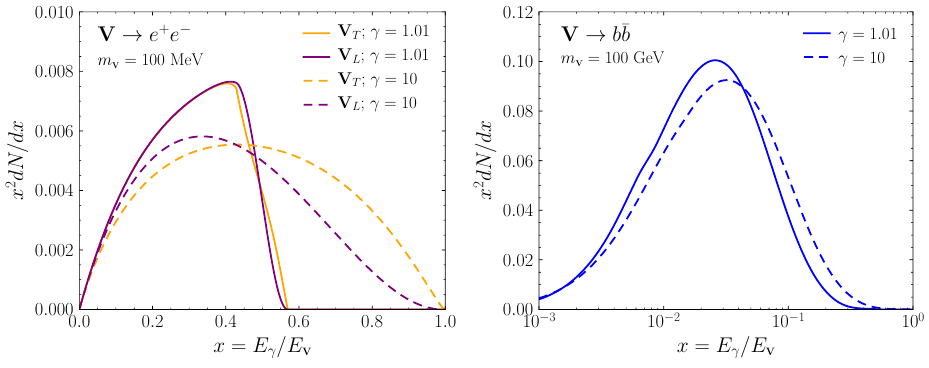
Figure 7: Example observer frame photon spectra for the case of a vector decaying to e + e − (left) and b ¯ b (right). For the electron final state, we take m show the spectrum for transverse and longitudinally polarised V , which in this case can have a significant impact on the spectrum. For the coloured final state, we take = 100 GeV, and now do not distinguish between polarisations (as described in the m V text there is not an appreciable difference between these for hadronic final